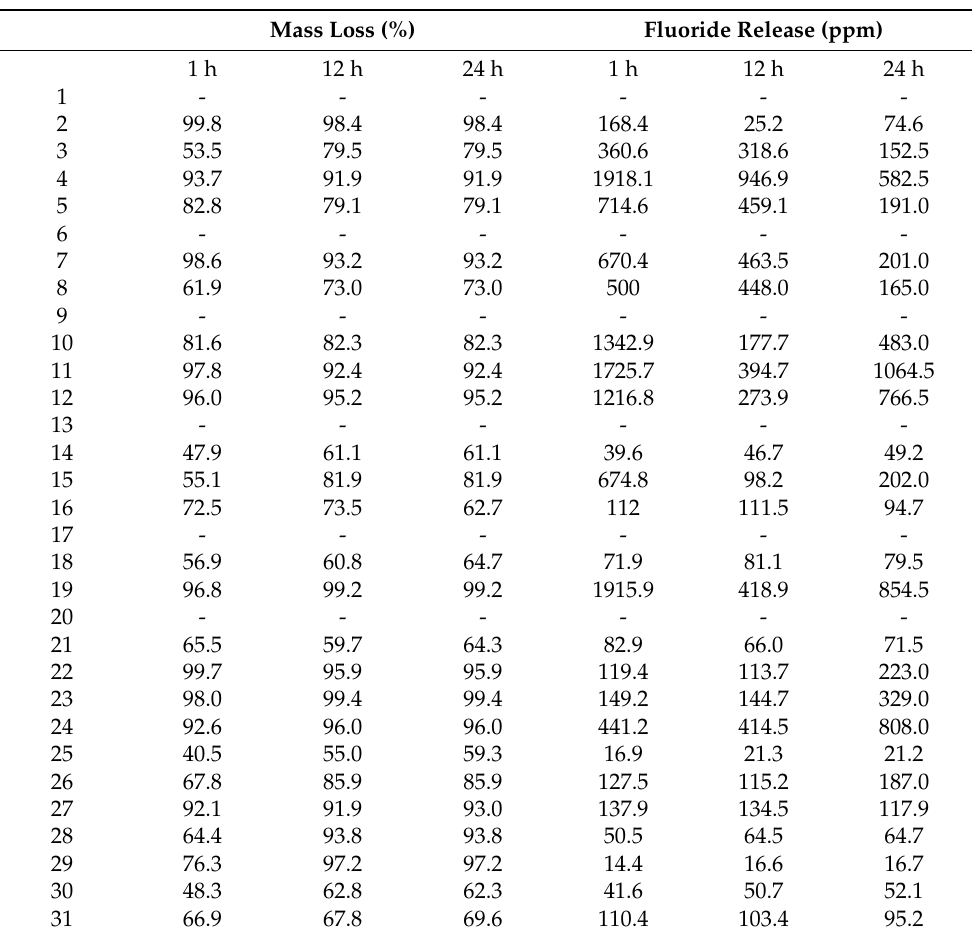
Table 5. The mass loss and fluoride release values following incubation of glass powders in TRIS- buffered saline, compositions without reported values yielded insufficient materials for processing and